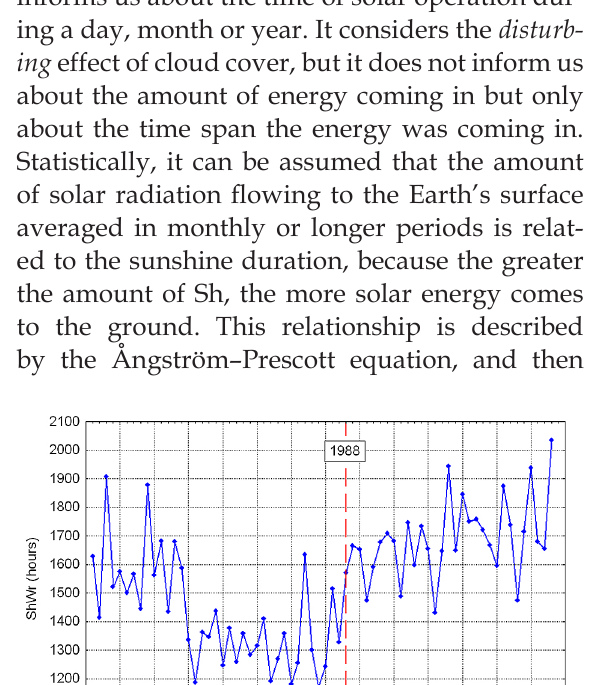
Table 2. Values of correlation coefficients (r) between monthly and annual sunshine, and monthly and annual air temperature in Wrocław (1951–2018) along with their statistical significance ( p ).